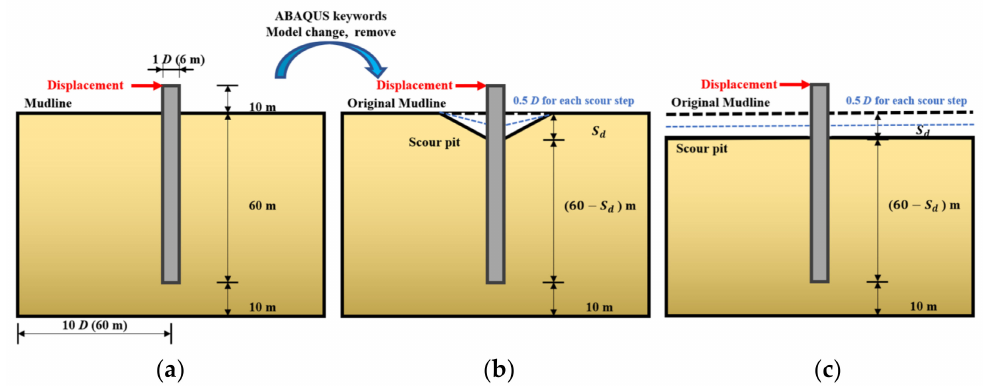
Figure 3. Schematic diagram of numerical modeling procedures in ( a ) no scour condition; ( b ) local scour condition; ( c ) general scour